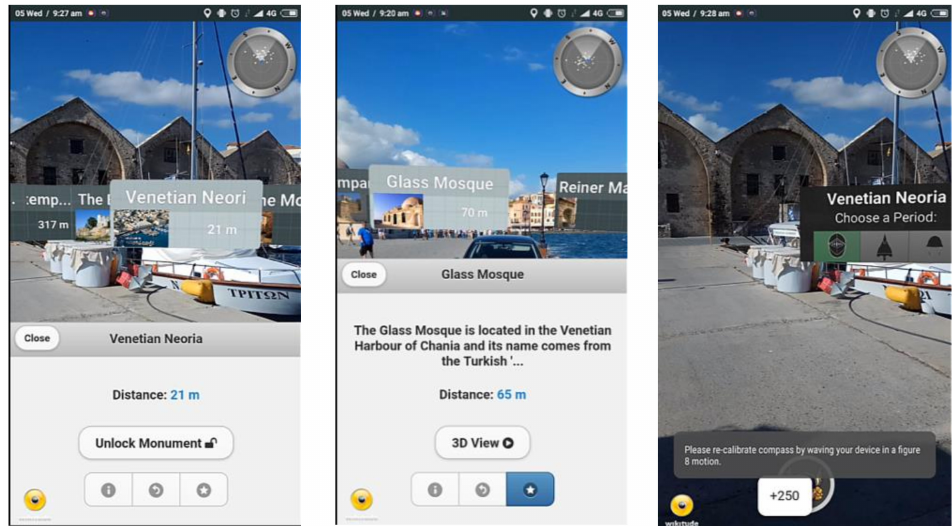
Figure 12. Navigation and classification in the camera